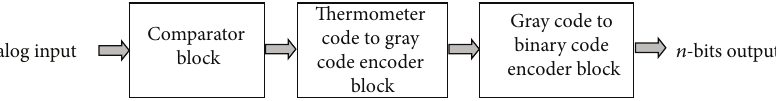
Figure 2: The proposed flash ADC